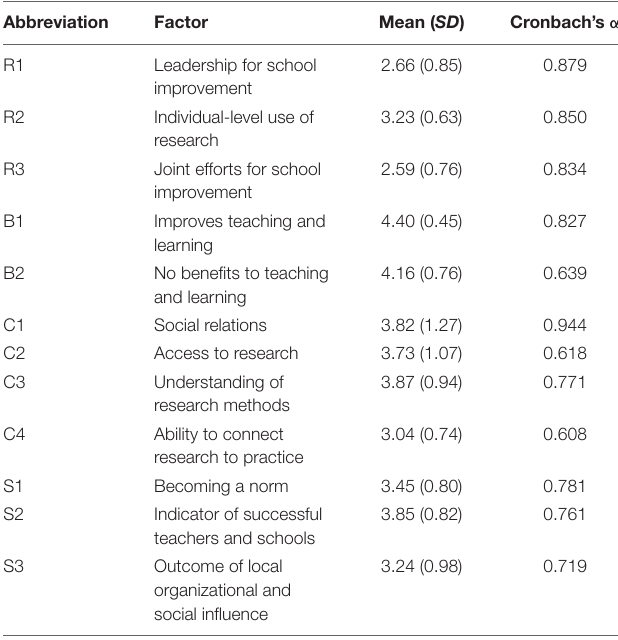
TABLE 4 | Descriptive statistics of the research-use factors.